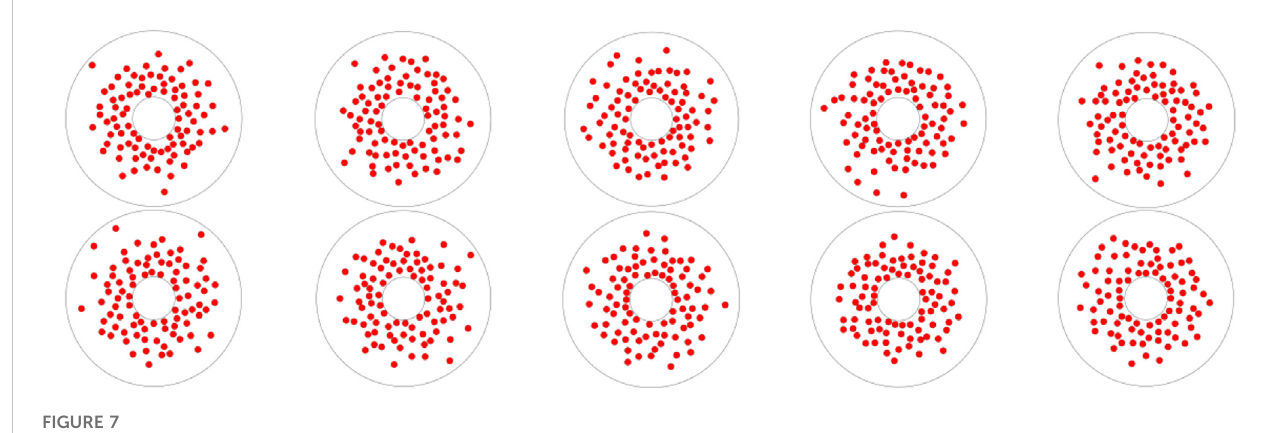
FIGURE 7 Optimal layout of NMC simulation 10 times.